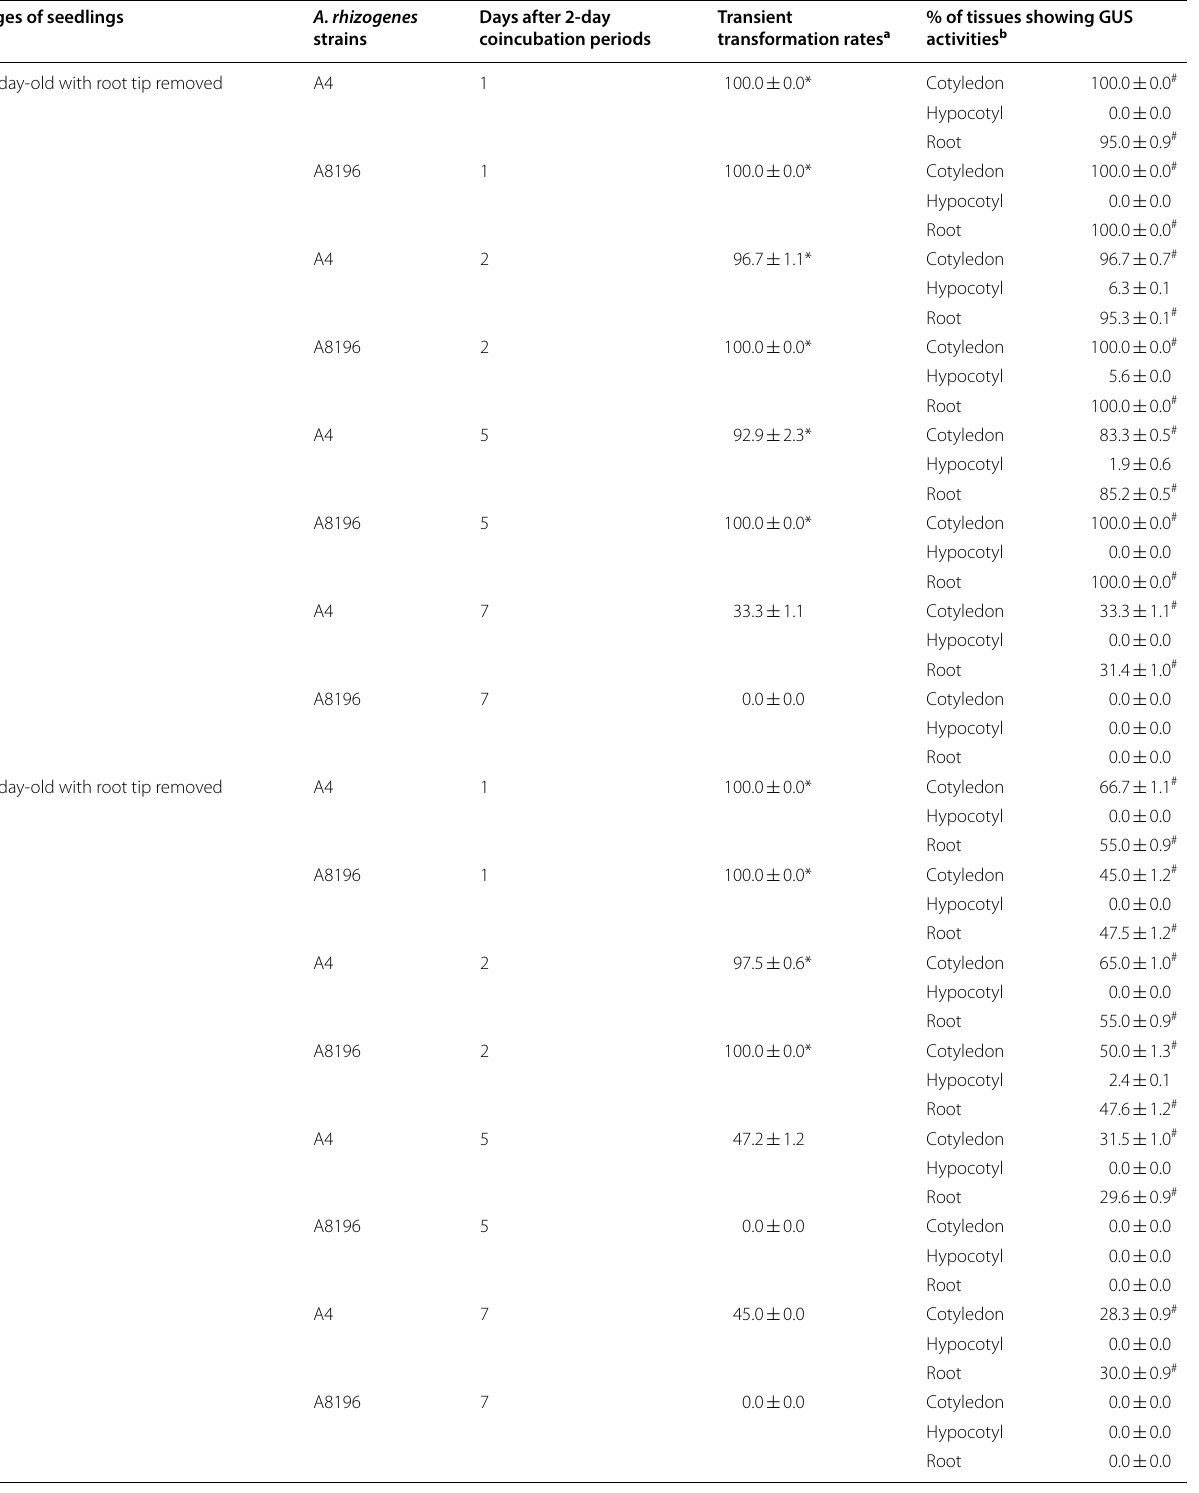
Table 2 Transient transformation rates of A. rhizogenes A4 or A8196 strain harboring the pCAMBIA1303 plasmid in ice plant seedlings and distributions (%) of GUS staining in different tissues of 3- and 5-day-old ice plant